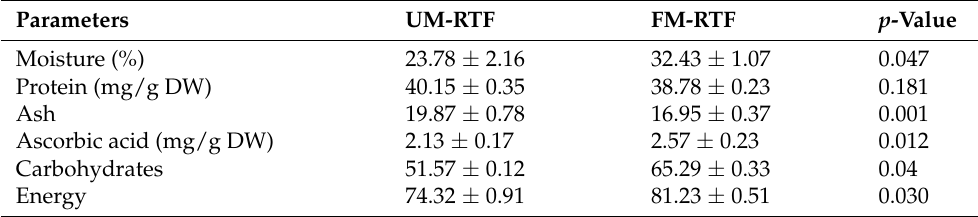
Table 1. Proximate composition, free sugars, organic acids, amino acids compositions and phenolic contents of R. tomentosa fruit in two ripening stages. One-way ANOVA was used to evaluate the statistical